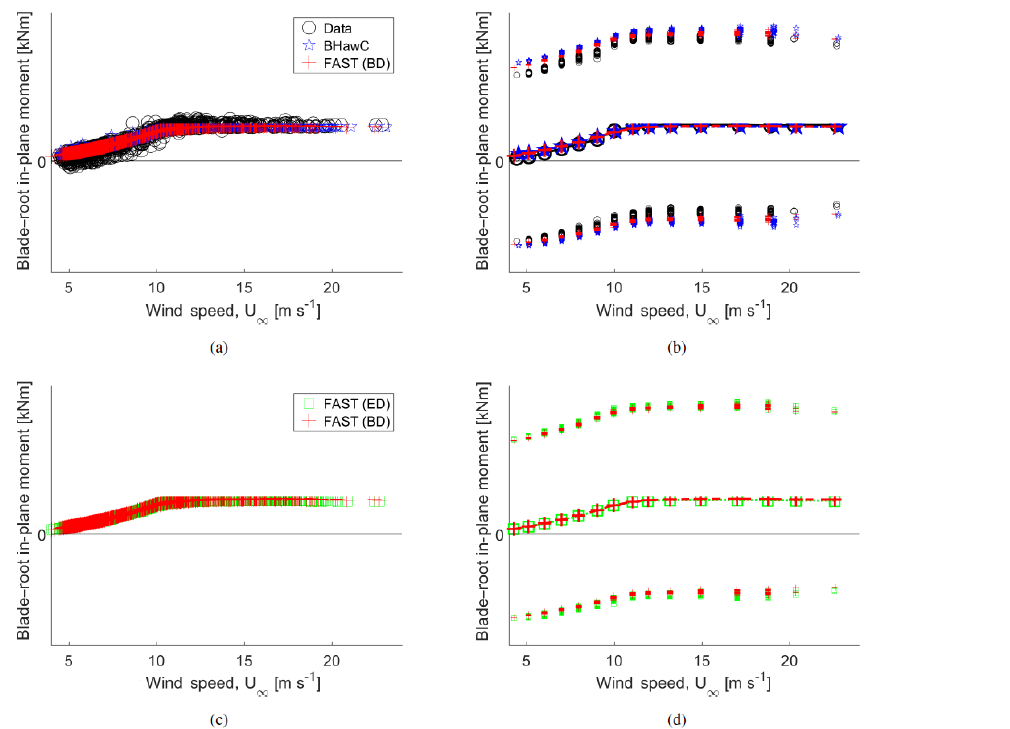
Figure 6. Blade-root in-plane bending moments. (a) Individual 10min averages from experimental data, BHawC, and FAST (BD). (b) Binned averages of data in (a) are denoted by points connected by lines; the scatter above and below these data denotes plus or mi- nus 1 standard deviation, respectively, of the individual 10min data sets in that bin. (c) Individual 10min averages from FAST (BD) and FAST (ED). (d) Binned averages of data in (c) are denoted by the points connected by lines; the scatter above and below these data denotes plus or minus 1 standard deviation, respectively, of the individual 10min data sets in that